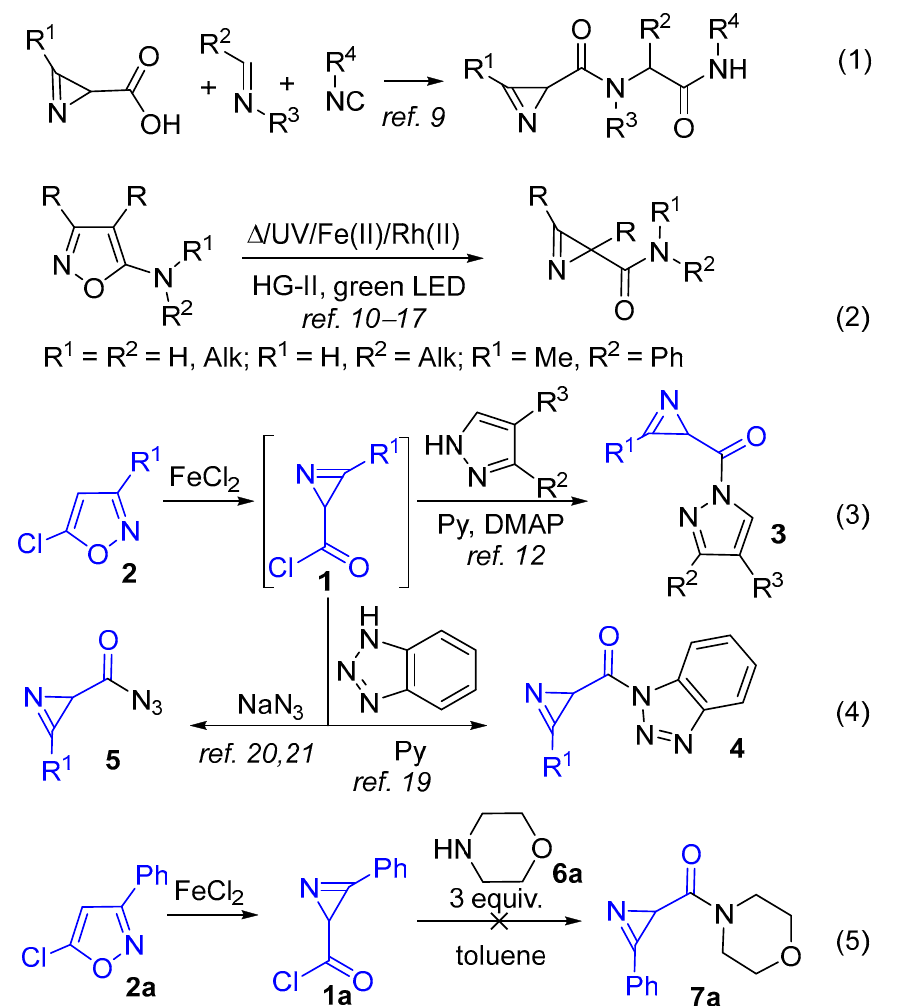
Scheme 1. Approaches to the synthesis of 2 H